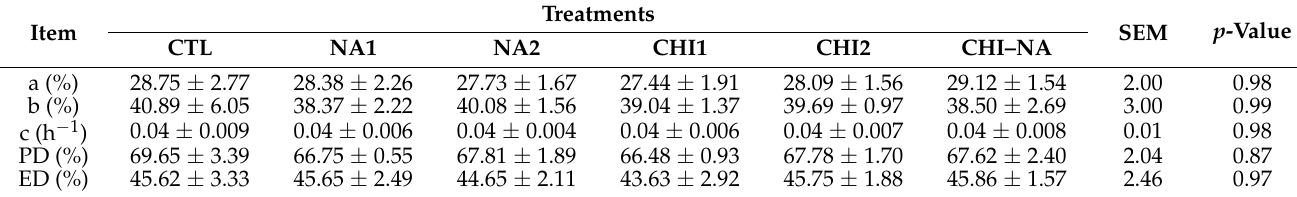
Table 5. In situ rumen degradation kinetics, potential degradability, and effective degradability of treatments.